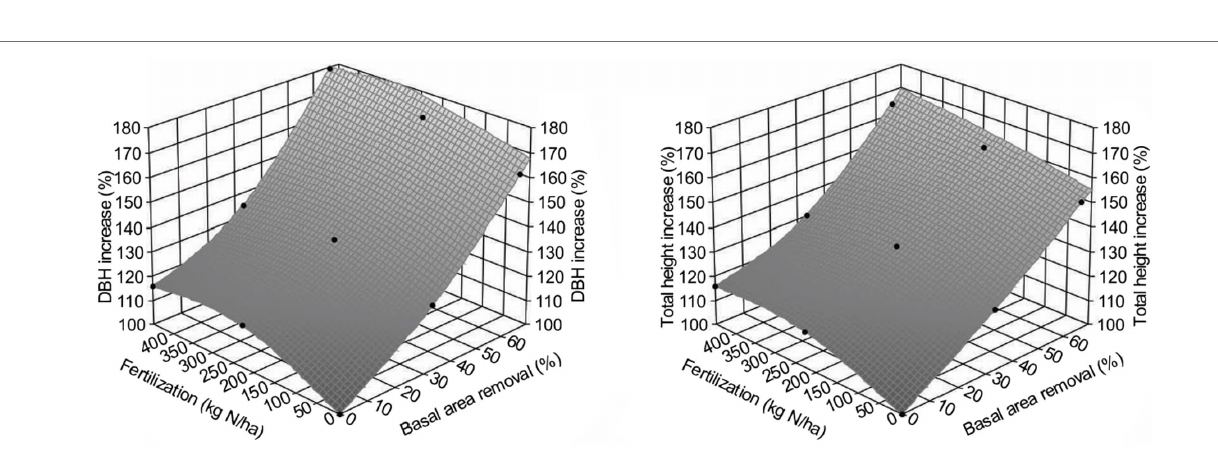
FIGURE 7 | Effect of different treatments combinations on average increase of diameter at breast height (DBH; 1.3 m; left) and total height (right) for Douglas-fir ( Pseudotsuga menziesii Mirbel) trees, 40 years after application at the Shawnigan Lake trial in British Columbia,